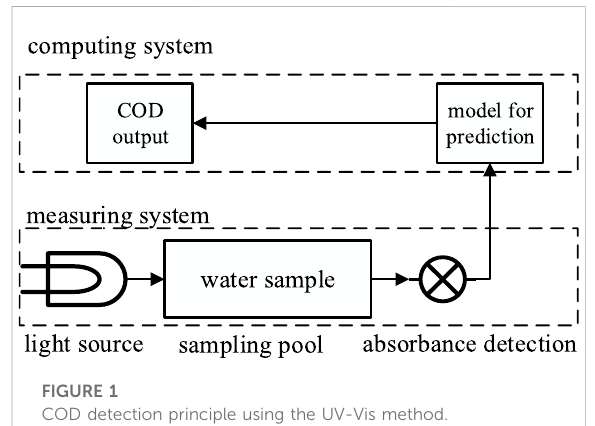
FIGURE 1 COD detection principle using the UV-Vis